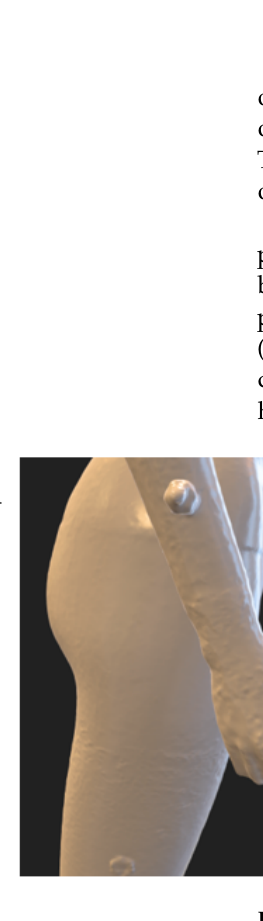
Figure 15. The illustration of camera configuration and visibility as well as the results of the exper- imental tests of the HUBO scanner for variants d1 and d2.